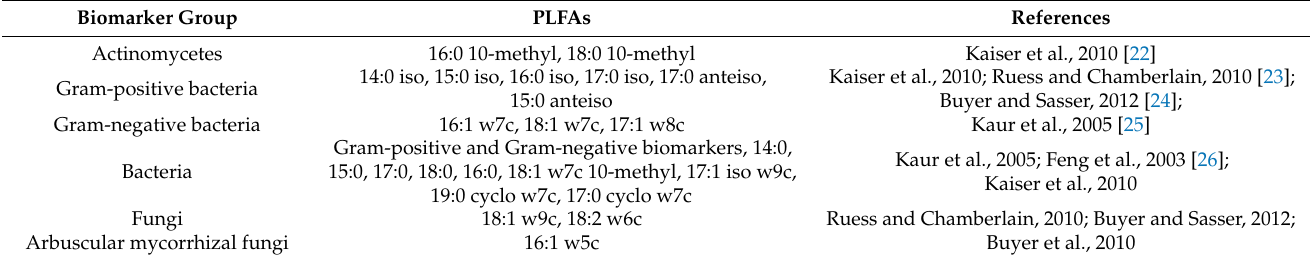
Table 2. Defined biomarker